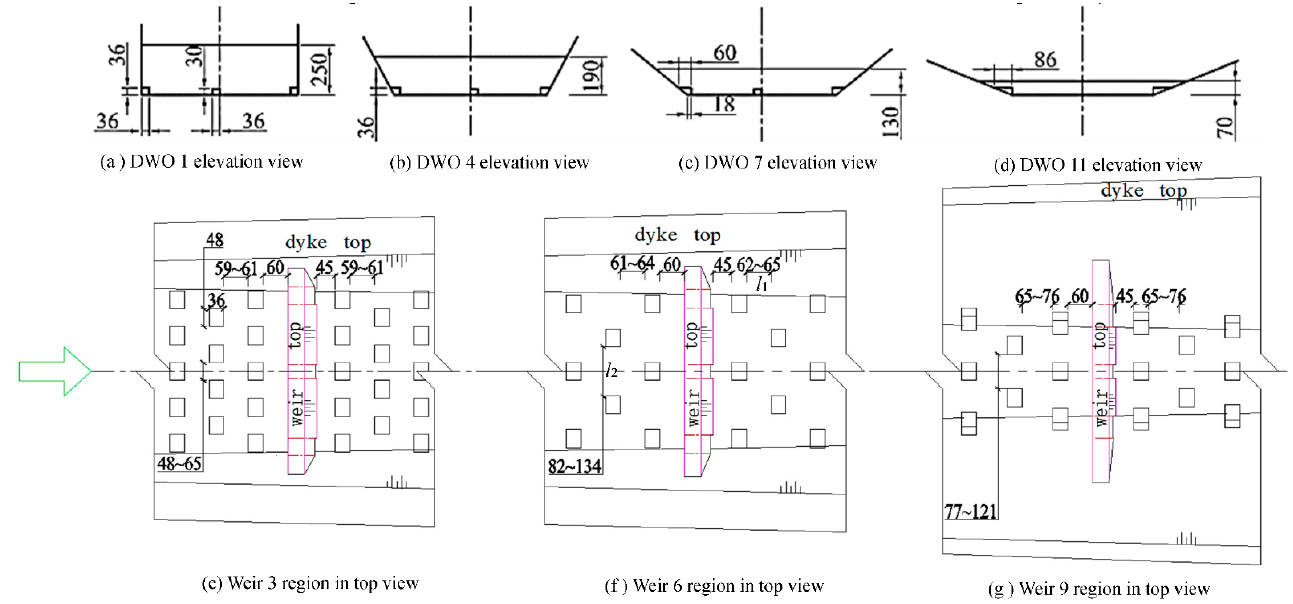
Figure 7. Sketch of DWO and roughness boulders (unit: cm). The elevation view of the DWO 1, 4, 7 and 11 are shown in panels ( a – d ), which includes three orifices in each weir plate. The DWO structure can be divided into three typical regions (including three weirs), as shown in ( e – g ). The roughening blocks are arranged symmetrically with the central axis of the channel, and the blocks upstream and downstream from the orifice are also arranged symmetrically. The roughening boulders were sampled as cubic blocks in the hydraulic model, as shown in the figure.